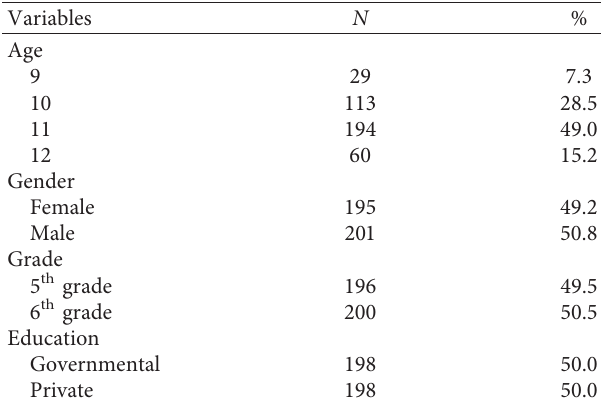
Table 1: Distribution of the sample size according to age, gender, grade, and education.